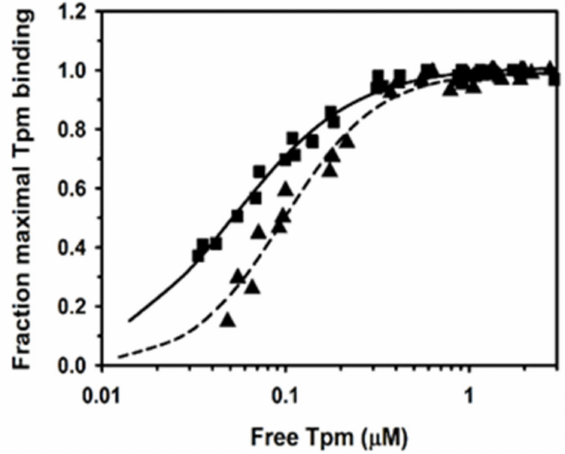
Figure 1. Binding of tropomyosin isoforms to F-actin. Tpm1.1 (triangles, dashed line), Tpm3.12 (squares, solid line) binding to 3 µ M F-actin in 100 mM NaCl, 2.0 mM MgCl 2 , 1 mM DTT, 5.0 mM Tris–HCl, pH 7.5. The points are from three experiments. The lines show fitting of the experimental points to Equation (1). Table 1. Parameters of tropomyosin binding to F-actin in the presence and absence of cofilin-2. −